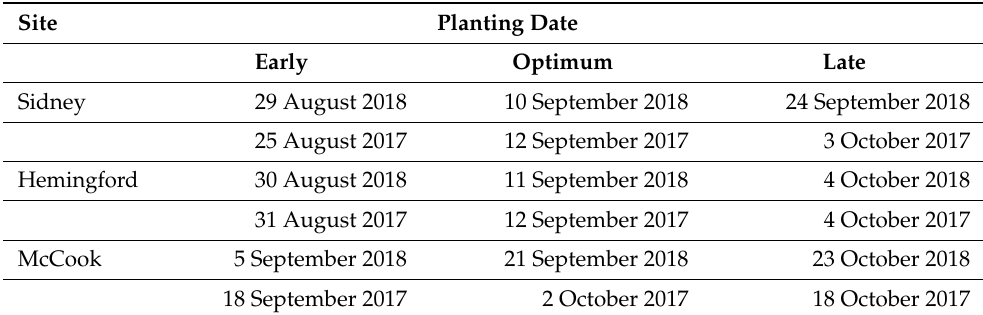
Table 1. Planting dates in 2017 and 2018 for winter wheat planted at Sidney, Hemingford, and McCook. Site Planting Date Early Optimum